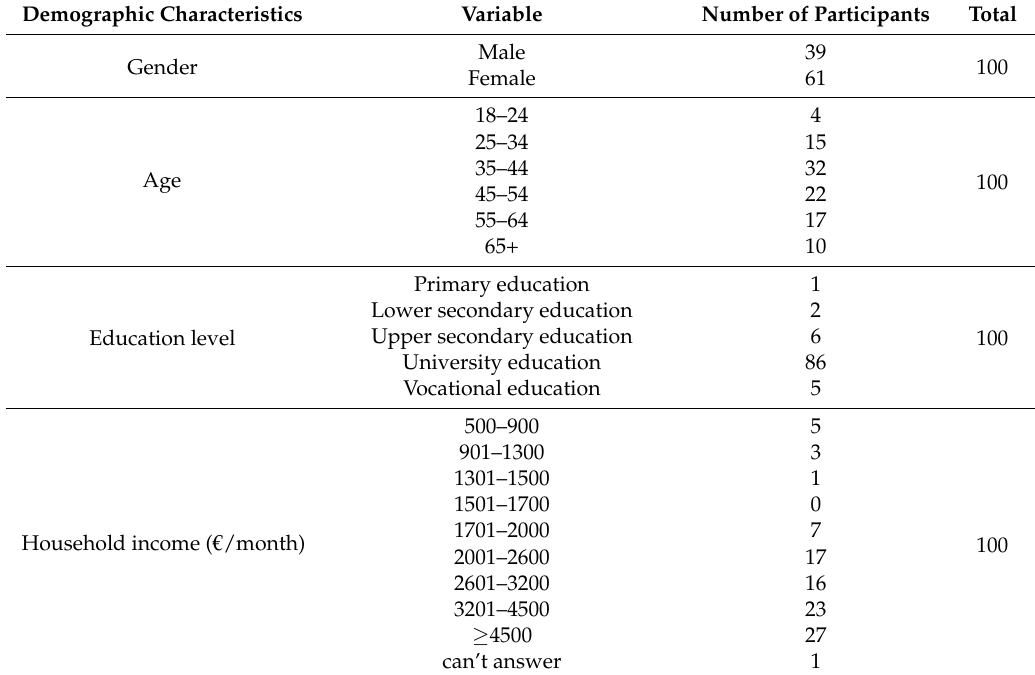
Table 2. Demographic description of participants ( N =